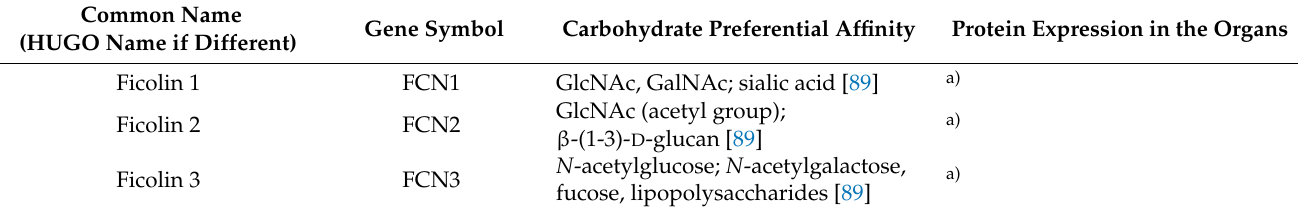
Table 5. Human ficolins, their carbohydrate ligands and protein expression in the organs.